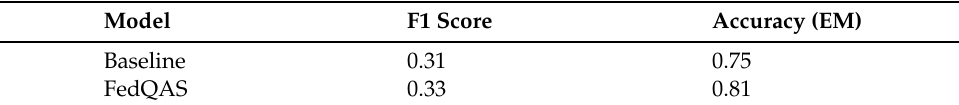
Table 4. Comparisons with equivalent parameters on the validation set of SQuAD1.0.